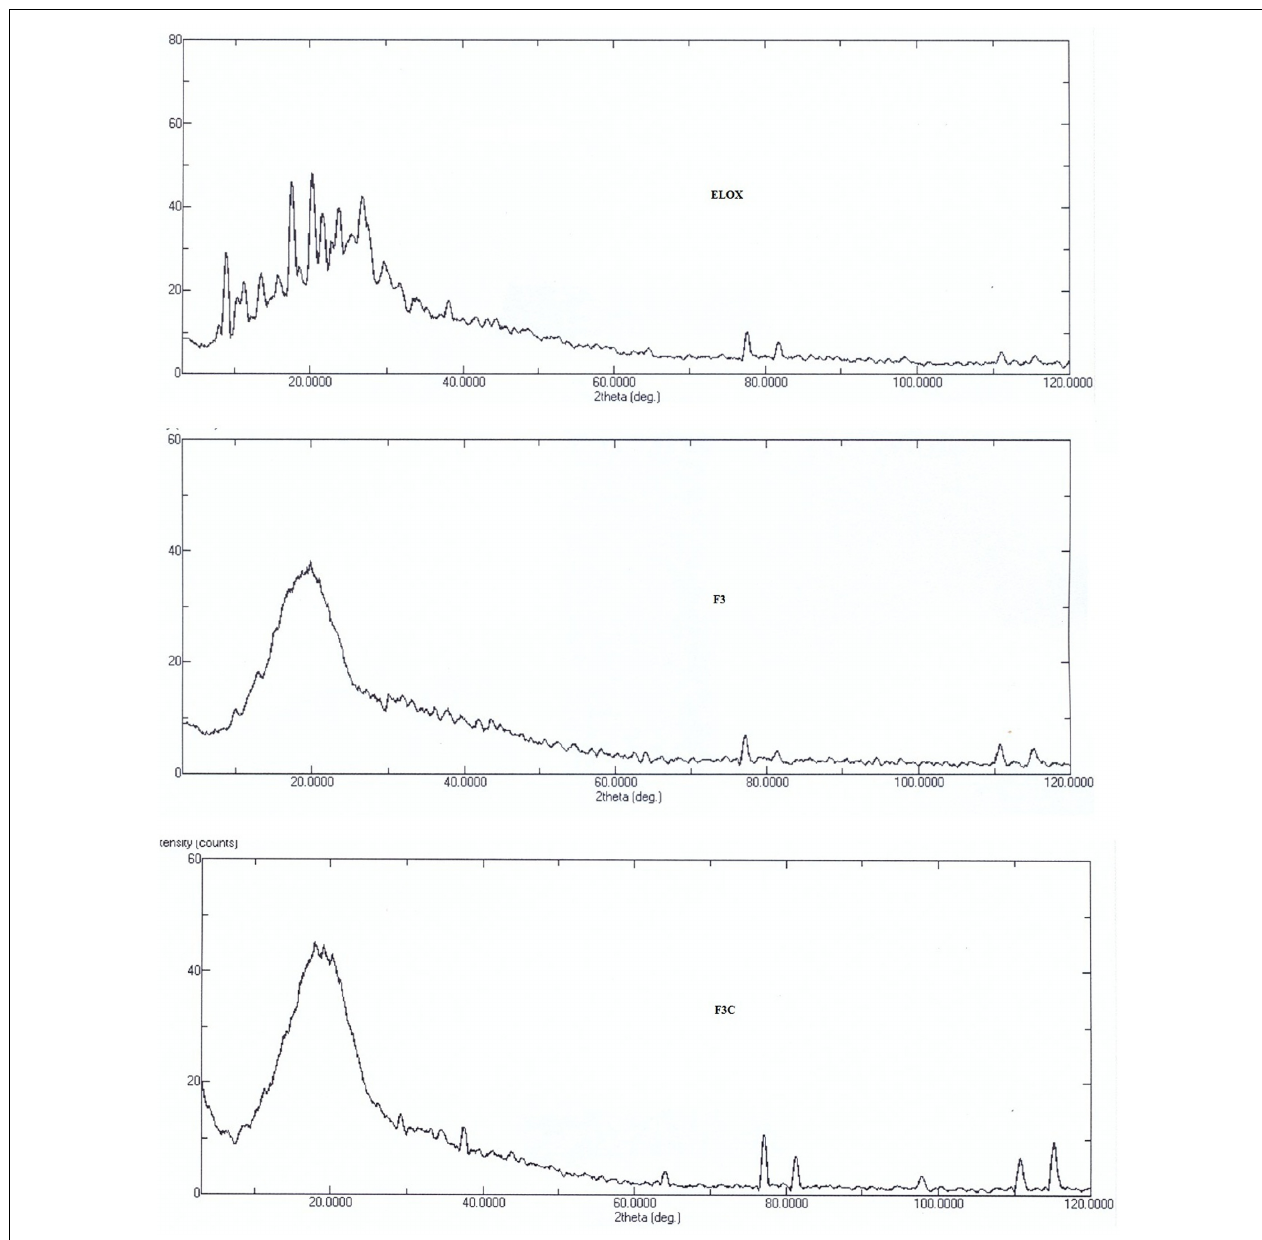
FIGURE 5 | XRF spectra of ELUX, plain and coated PLGA